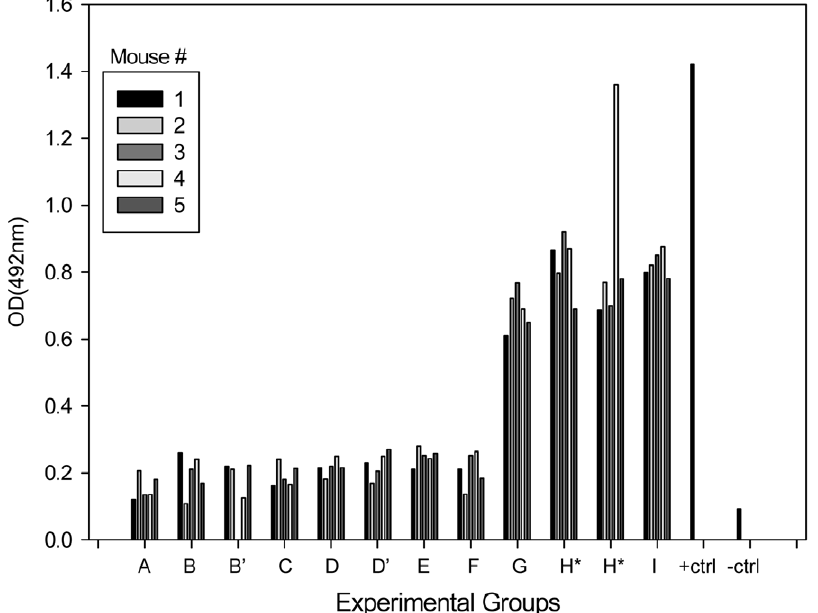
Figure 6. Vaccination induced appearance of serum antibodies regardless of colonization status. All mice immunized with the Fba vaccine (groups G, H, H’ and I) developed serum antibodies against the Fba immunogen. Note that the sera from groups H and H’ were not properly marked for identification of H or H’ and were, thus, both designated as H* and H*.